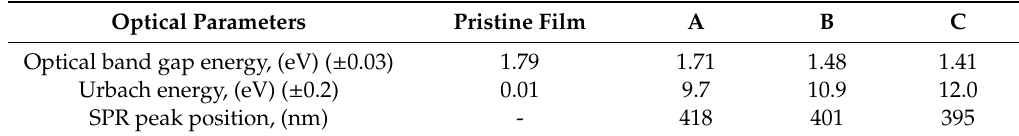
Table 2. Summary of major optical parameters for pristine a-C and the respective Ag:a-C films. Optical Parameters Pristine Film A B C Optical band gap energy, (eV) ( ± 0.03) 1.79 1.71 1.48 1.41 Urbach energy, (eV) ( ± 0.2) 0.01 9.7 10.9 12.0 SPR peak position, (nm) - 418 401